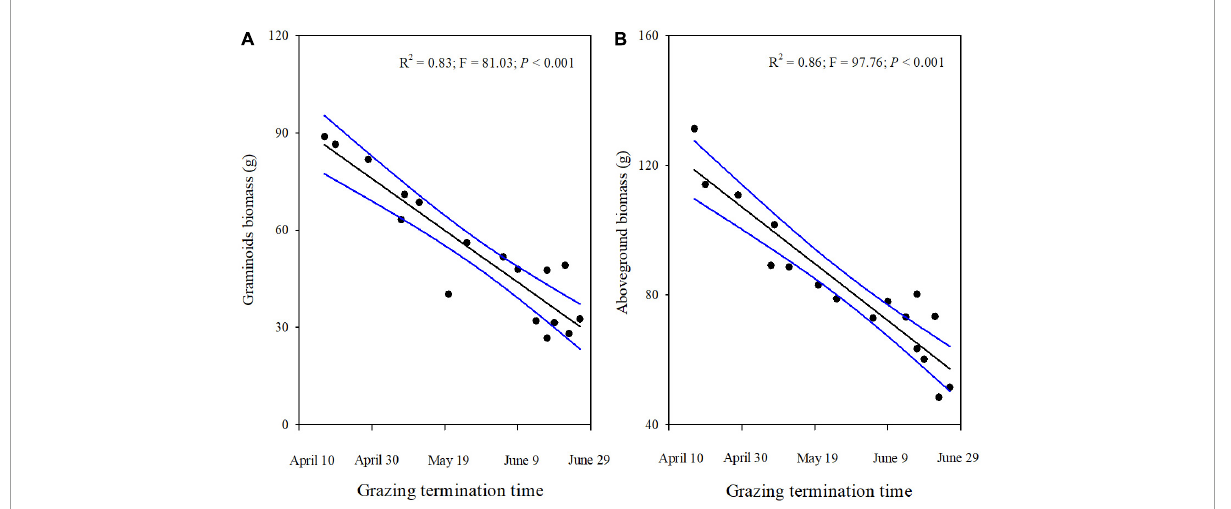
FIGURE4 The Graminoid biomass (A) and the aboveground biomass (B) for different grazing termination times on winter pastures in alpine meadows, according to a linear regression. The black lines indicate significant regression relationships and blue lines indicate the smoothed regressions with its 95% confidence intervals.